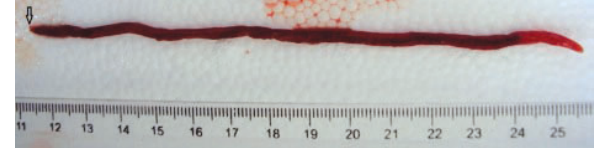
Figure 1. Dioctophyme renale removed from right kidney of Galictis cuja . Note: The black arrow indicates the male copulatory muscular bursa.